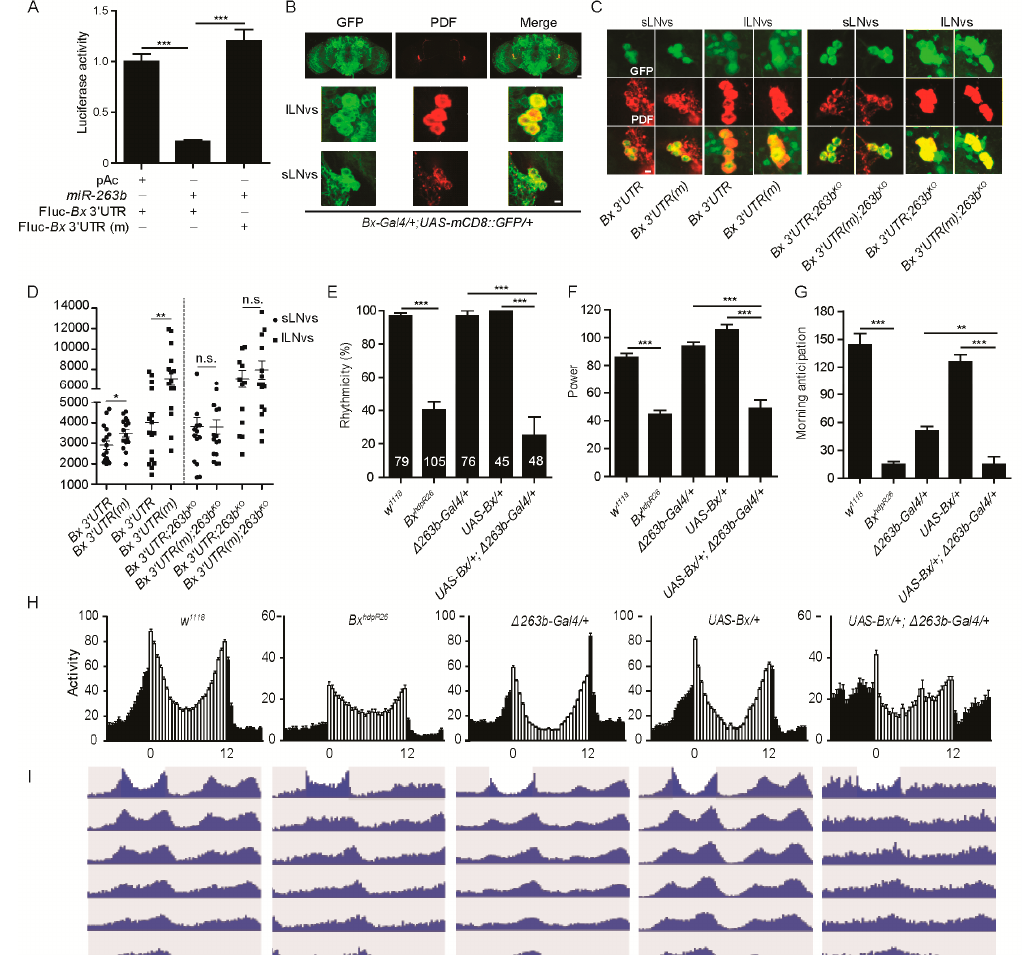
Figure 5. Bx regulates circadian rhythms, and its expression is suppressed by miR-263b. ( A ) miR-263b inhibited the expression of Bx in S2 cells. pAC or pAC- miR-263b were co-transfected with pAc-fluc- Bx 3 ′ UTR or pAc-fluc- Bx 3 ′ UTR (mut) and with pCopia-Renilla luciferase into S2 cells. After two days, luciferase activity was quantified. For each condition, a normalized firefly/ Renilla luciferase value is plotted with SEM. ( B ) Bx is expressed in the PDF-positive sLNvs and large LNVs (lLNvs). Representative confocal images of fly brains (scale bar, 75 µm), lLNvs, and sLNvs (scale bar, 10 µm) stained for GFP (green) and PDF (red) dissected at ZT13. ( C ) Representative confocal images of Bx 3 ′ UTR ( Bx-GAL4/+; UAS-EGFP-Bx 3 ′ UTR/+ ) and Bx 3 ′ UTR (mut) ( Bx-GAL4/+; UAS-EGFP-Bx 3 ′ UTR(mut)/+ ) in wild-type or miR-263b mutant background. The brains were stained with anti-GFP antibody (green) and anti-PDF antibody (red) at ZT13; scale bar, 10 µm. ( D ) Quantification of GFP signals in sLNvs and lLNvs from Bx 3 ′ UTR and Bx 3 ′ UTR (mut) flies. Data represent means ± SEM ( n = 16–17); * p < 0.05, ** p < 0.01 determined by Student’s t -test. ( E – G ) Comparison of ( E ) rhythmicity, ( F ) power, and ( G ) morning anticipation in indicated lines. The numbers of tested flies are shown in each column. Each experiment was conducted three times. Data represent means ± SEM ( n = 45–105); ** p < 0.01, *** p < 0.001 determined by Student’s t -test. ( H ) Locomotor activity of adult male flies of the indicated genotypes measured during three days of LD cycle. The white and black bars indicate day and night, respectively. ( I ) Actograms showing the average activities on the last day in LD and the five days in DD. Light represents the day, and gray represents darkness.